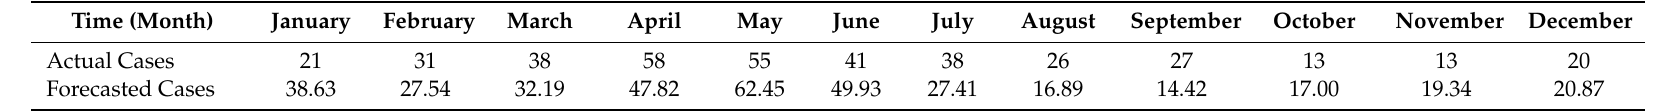
Table 2. Comparison of observed and forecasted mumps from January to December in 2014 by the SARIMA (0, 1, 1) (0, 1, 1) 12 model.